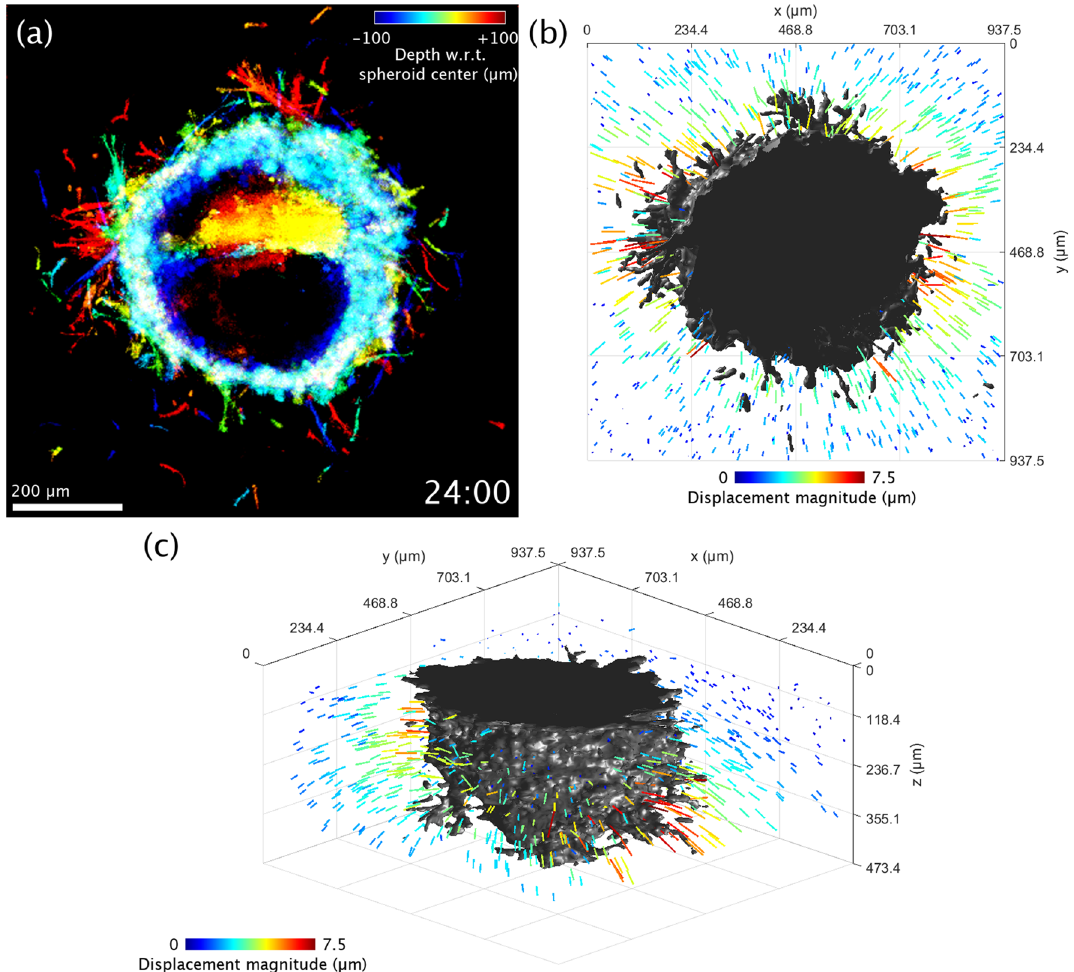
Figure 4. Visualization of 3D collagen displacements in the vicinity of an obese ( ob / ob ) ASC + MCF10AT1 co-culture spheroid at time t = 24 h. ( a ) Top-down view of the spheroid, using the same depth-to-color projection as in row 3 of Figs. 1 and 2. ( b ) Top-down rendering of the spheroid (shown in gray) accompanied by colored arrows which indicate displacement of the collagen matrix as measured with respect to its initial configuration at time t = 0 h. Arrow lengths have been exaggerated for visualization purposes. ( c ) Re-rendering of ( b ) from an isometric viewing angle. The flat surface of the spheroid corresponds to a region where the spheroid comes into contact with the coverslip bottom of the petri dish. Time-lapse animation is available in Supplementary Video the image is assigned a unique color based on its distance from the plane shown in rows 1 and 2, and the final image is obtained via a maximum intensity projection of each color channel along the depth axis. Rows 4 and 5 depict 3D renderings of the ‘cell channel’, where row 4 shows the surface of the spheroid from an isometric view- ing angle, and row 5 shows a ‘cutaway’ which reveals the interior structure of the spheroid. The wildtype (WT, lean) ASC monoculture spheroid in Fig. 1 retains a solid/confluent internal structure over time, whereas the WT ASC + MCF10AT1 co-culture spheroid in Fig. 2 exhibits a central ‘core’ of cells which detached from the exterior ‘shell’ and migrated along the depth axis until it was no longer visible to the imaging system. The presence of these distinct structures in the co-culture spheroid is consistent with histology, such as that shown in Fig. S1 of Ref. 31 . Label‑free scattering contrast provides visualization of collagen degradation. In addition to the ‘cell’ and ‘collagen’ channels discussed above, we also observed a third feature in the image data: ‘voids’. These regions of low scattering signal correspond to one of two features: (1) areas which cells initially occu- pied but vacated over time, leaving behind fluid-filled spaces and cavities, or (2) areas in the collagen substrate which have been degraded by invading cells (and are not currently occupied by cells). Both of these features are depicted in Fig. 3, with Fig. 3c highlighting regions of newly degraded collagen, in particular. The ability to identify these modifications to the collagen substrate is potentially useful for studying the mechanisms underly- ing the collective invasion process 31 . Unfortunately, these regions are also (currently) prohibitive to conducting